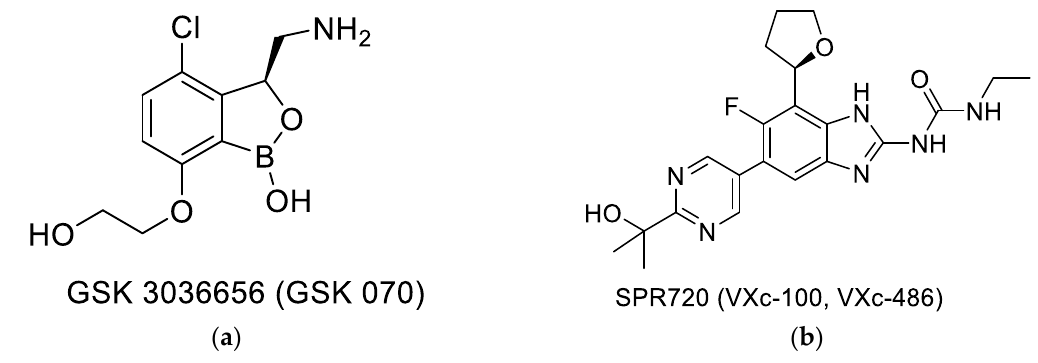
Figure 2. Two novel compounds that have entered clinical development ( a ) GSK070 and ( b )